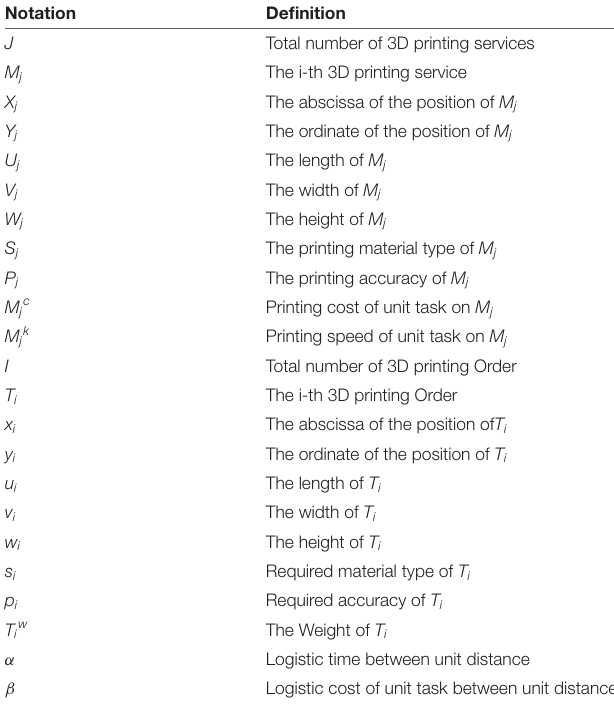
TABLE 1 | Main mathematical